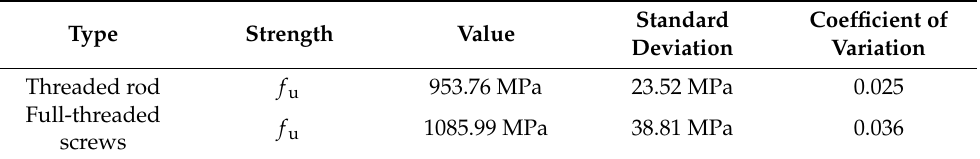
Figure 6. Tension test: ( a ) threaded rod; ( b ) full thread screw; and ( c ) test specimens. Table 3. Evaluation of the tension test of fasteners. A total of six specimens were tested for each type of fastener. The load – deformation diagrams of the individual tests are shown in Figure 7.